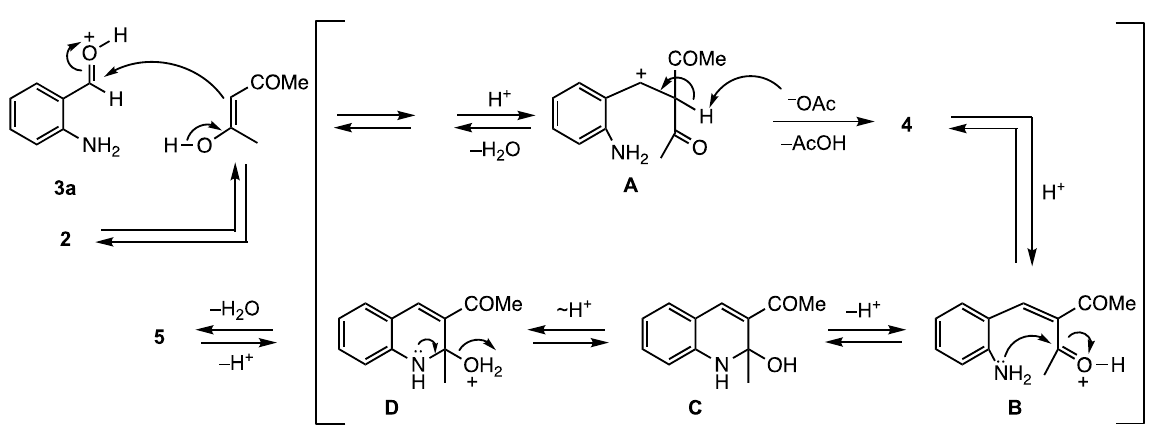
Scheme 3. Mechanism for the Friedländer reaction under acidic conditions showing reaction of 3a with 2,4-pentanedione ( 2 ) to give quinoline 5 .